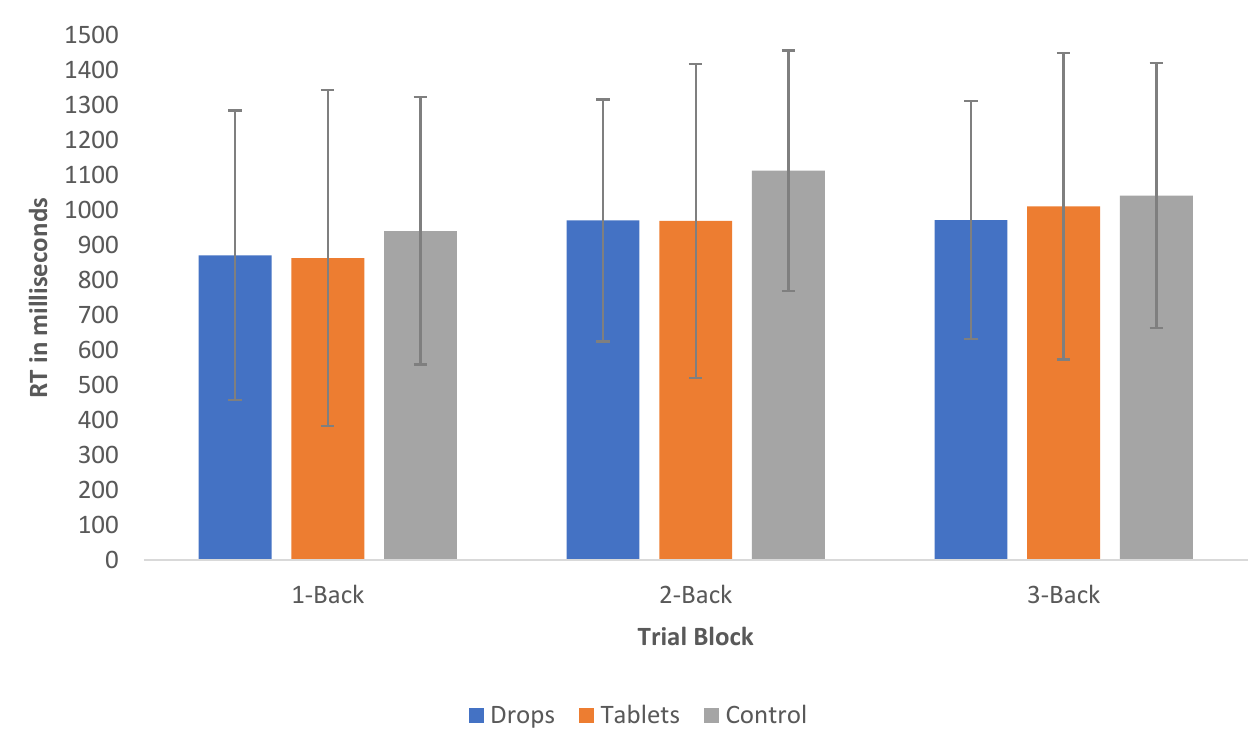
Figure 1. Mean RT and standard deviation of the 1-back, 2-back and 3-back trials of CBD sublingual drop users, CBD tablet users and the control group.